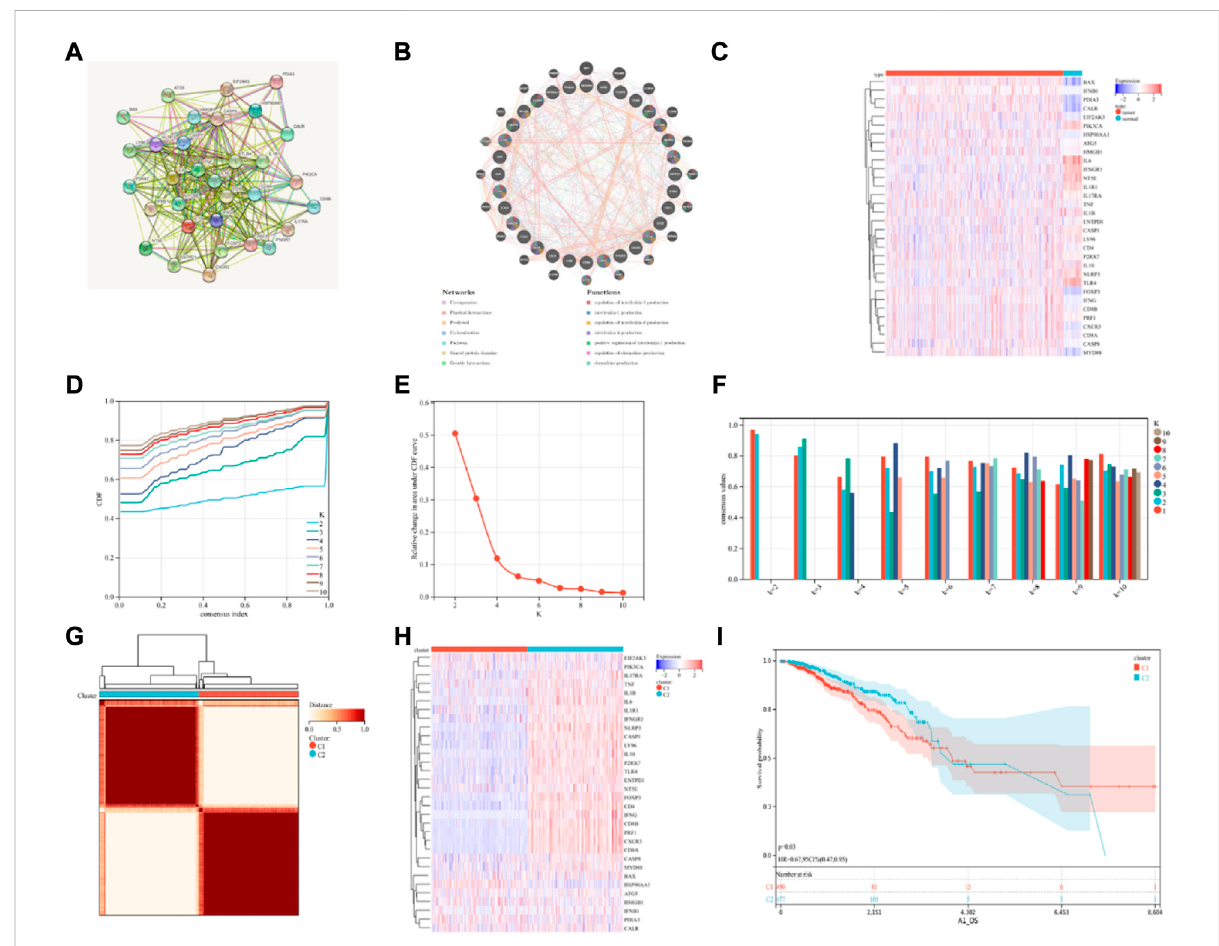
FIGURE 1 Consensus clustering identi fi cation of ICD-related subgroups. (A) Protein-protein interactions among the genes related to ICD using STRING; (B) Protein-protein interactions among the genes related to ICD using GeneMANIA; (C) Heatmap displaying the expression of 32 ICD genes in the BRCAandnormaltissuesamplesusingtheTCGAdatabase; (D – F) Theconsensusclusteringdeltaareacurveshowstherelativedifference(variations) in the area under cumulative distribution function (CDF) curve when k = 2 to 10; (G) The consensus clustering solution (k = 2) for 32 genes